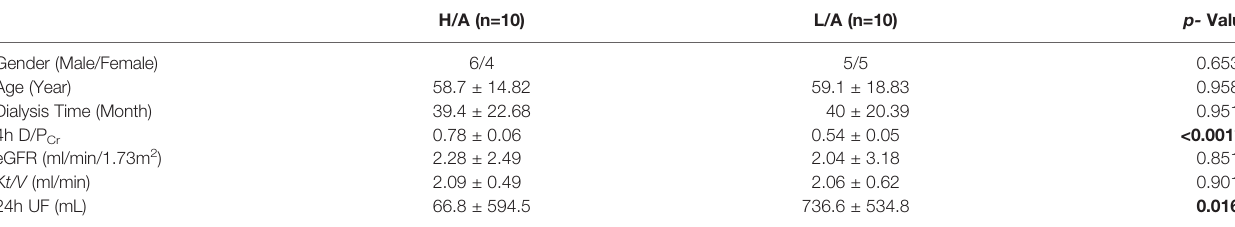
TABLE 2 | Demographic and clinical characteristics of subjects in screening cohorts.